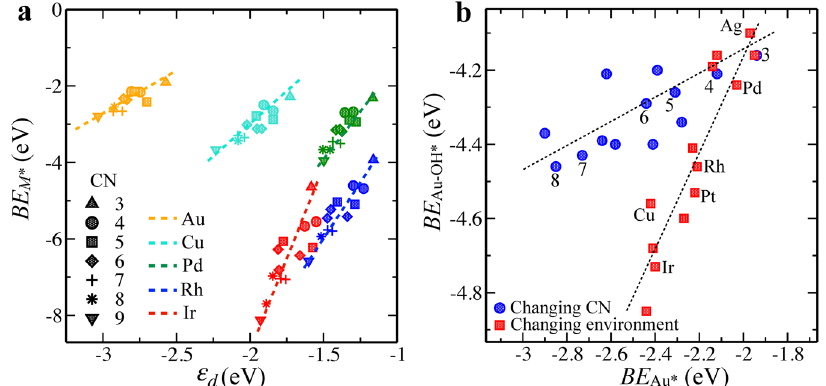
Fig. 3 Variation in site stability as a function of d -band center, coordination number and change in site environment. a Metal atom stability as a function of the change in d -band center ( ε d ) and coordination number (CN) on fcc (100), (111), and (211) surfaces with varying number of surface adatoms. Linear fi ts to the points for each metal are shown with dashed lines. b The binding energy of metal-adsorbate complexes (ontop site adsorption) as a function of the binding energy of the metal atom for pure Au (blue points) and Au surface alloys (red squares). The blue points re fl ect changes in CN, whereas red squares designate changes in the local chemical environment 72